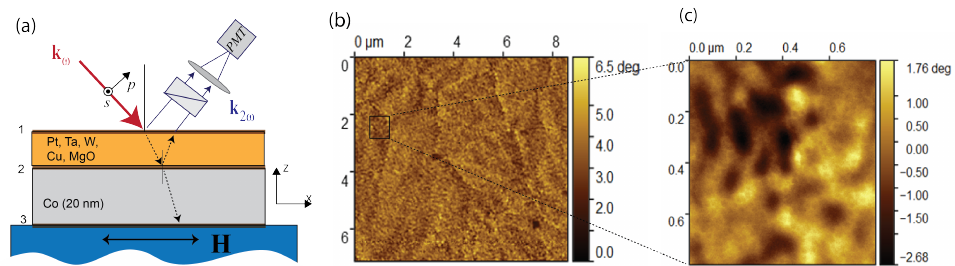
Figure 1. ( a ) Scheme of the experimental configuration for the SHG studies; p- or mixed SHG polarizations were detected, with the magnetic field H being parallel to the film surface and to the plane of incidence; ( b , c ) magnetic force microscopy images (at different scales) of Co(20)Pt(3)